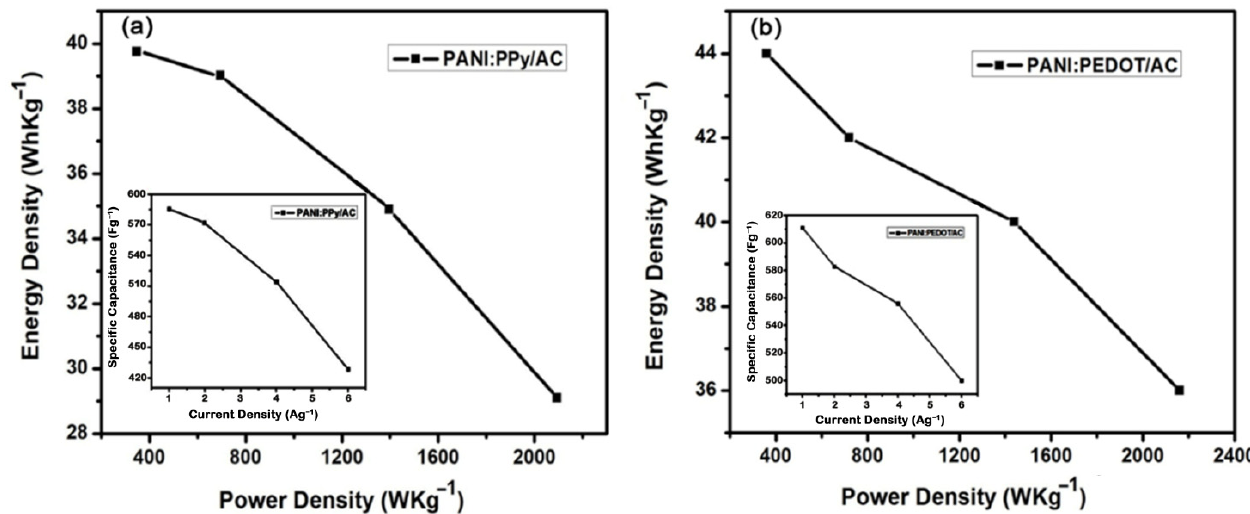
Figure 8. Ragone plot exhibiting energy density versus power density for ( a ) PANI:PPy/AC and ( b ) PANI:PEDOT/AC.